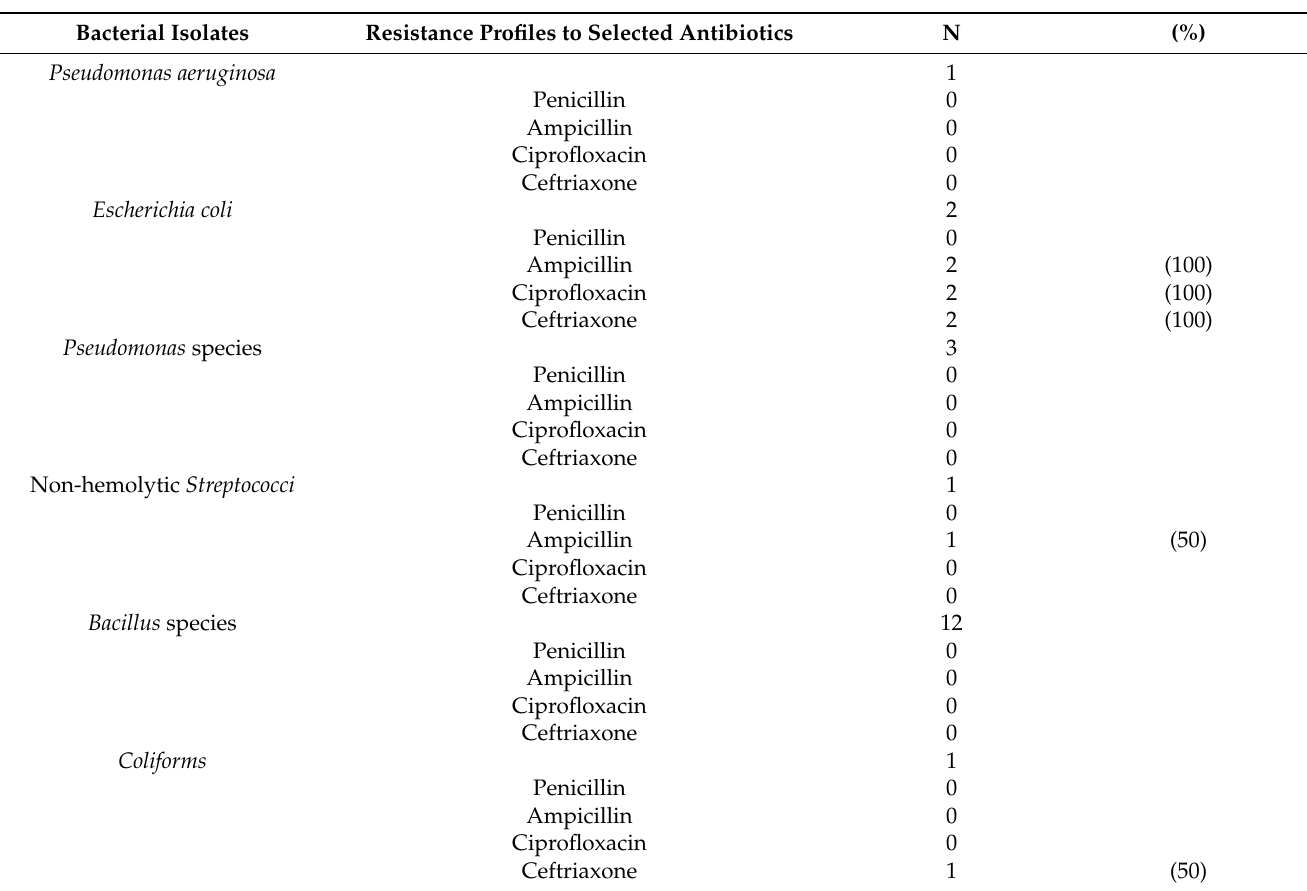
Table 4. Resistance profiles of bacterial isolates to selected antibiotics for the sites from which ambient air was sampled in urban Accra, Ghana (February 2020). Bacterial Isolates